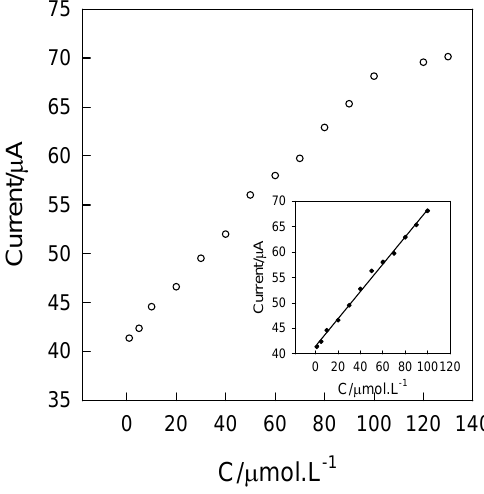
Figure 8. Steady state calibration curve of NA sensor in 0.1 mol·L -1 KCl (pH 10.0) at oxidization potential of 320.0 mV (vs